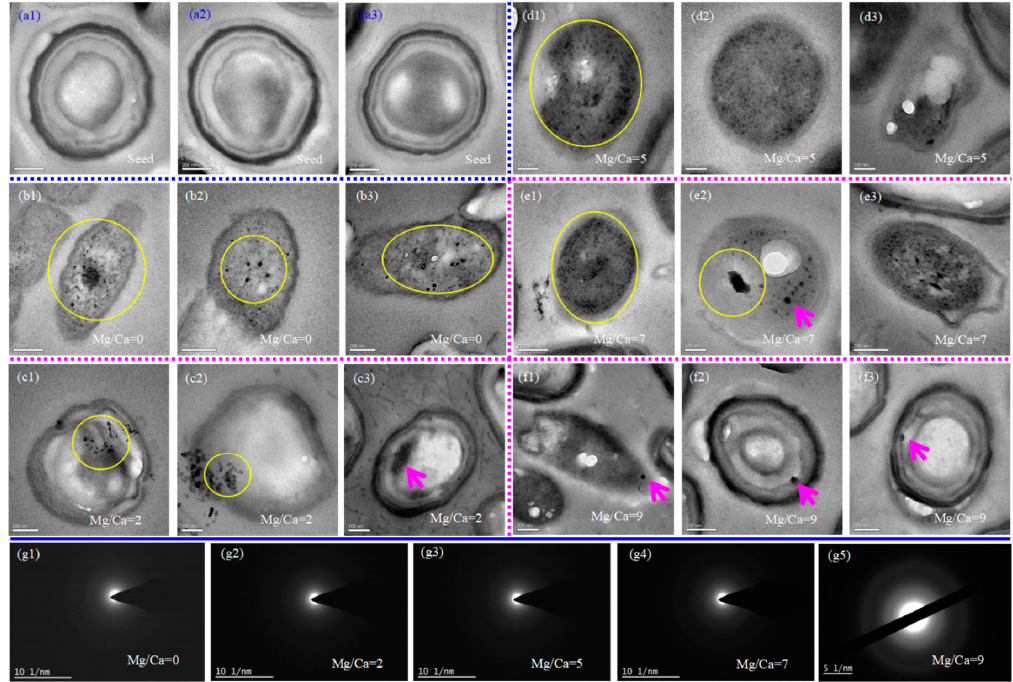
Figure 10. High-resolution transmission electron microscopy (HRTEM) and selected area electron diffraction (SAED) analyses of intracellular biomineralization of H. smyrnensis WMS-3 bacteria. ( a ), Bacterial seed; ( b )–( f ), Bacteria at Mg/Ca molar ratios of 0, 2, 5, 7, and 9, respectively; ( g1 – 5 ), SAED analyses of the intracellular inclusions of bacteria at Mg/Ca molar ratios 0, 2, 5, 7, and 9, respectively. (The arrows and the circles represent the location of biomineralization).